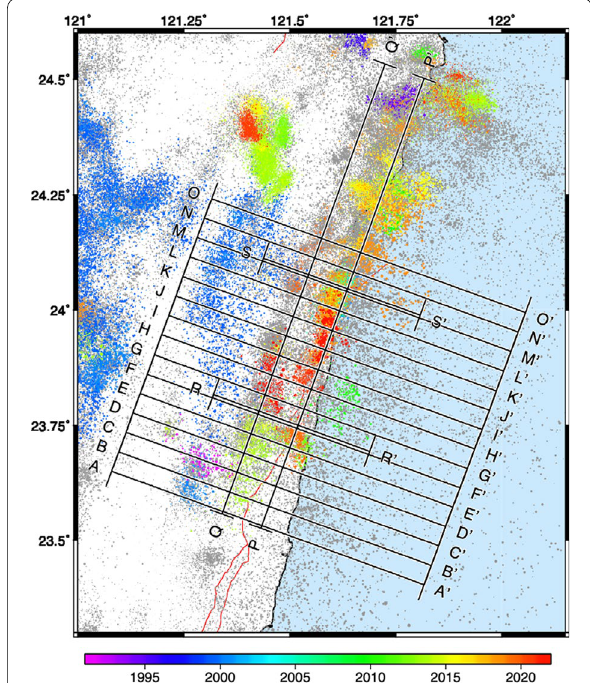
Fig. 3 Distribution of background seismicity (grey‑colored dots) and extracted earthquake clusters (colored dots) from January 1991 to August 2021. Locations for the profiles shown in Figs. 6, 7 and 8 are indicated as black lines